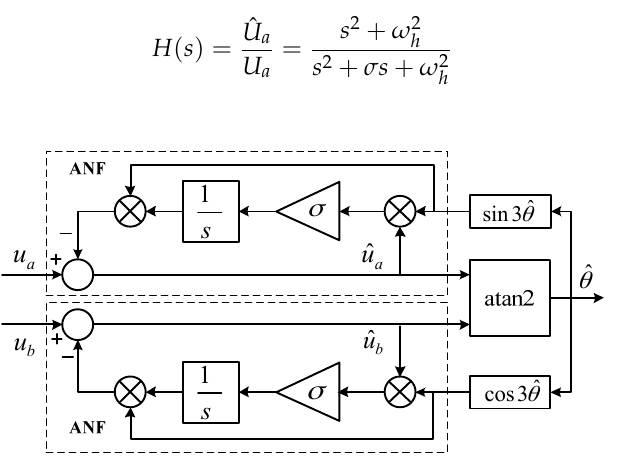
Figure 4. Diagram of ANF processing.